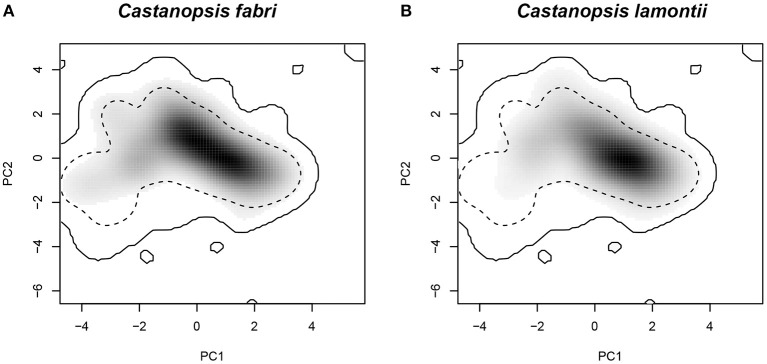
Climatic niche quantification based on principal component analysis-env ordination approach. (A) Niche occupied by C. fabri; (B) niche occupied by C. lamontii. The solid and dashed contour lines illustrate 100 and 50% of available environment.